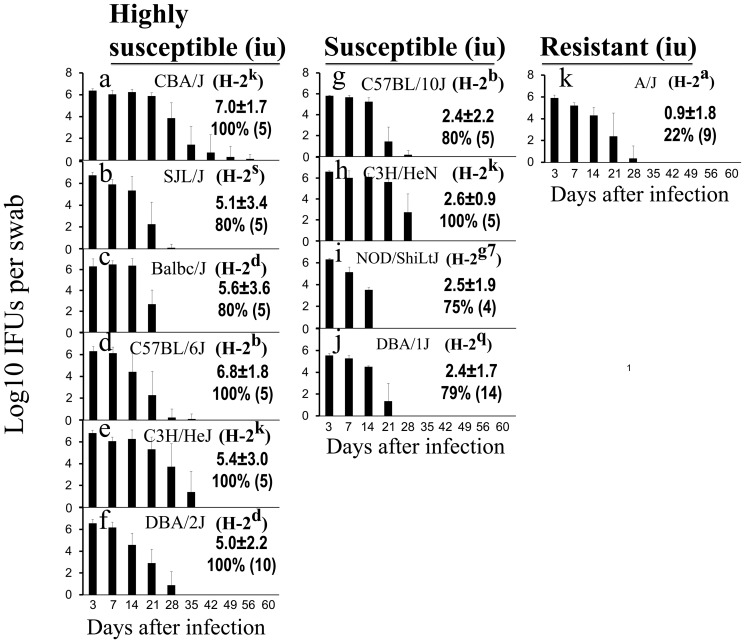
Hydrosalpinx development and live organism shedding following intrauterine infection with C. muridarum.Each of the 11 strains of mice was inoculated with 2×105 IFUs of C. muridarum via an intrauterine route (iu). Sixty days after inoculation, all mice were sacrificed for observing hydrosalpinx as described in Fig. 1 legend. Based on hydrosalpinx severity scores, the 11 strains were re-categorized into highly susceptible (with a median severity score of 5 or above, panels a-f for mouse strains CBA/J, SJL/J, Balb/cJ, C57BL/6J, C3H/HeJ & DBA/2J respectively), susceptible (<5 and >1, panels g-j for C57BL/10J, C3H/HeN, NOD/ShiLtJ & DBA/1J) or resistant (<1, panel k for A/J). The hydrosalpinx incidences (%) along with total number of mice per strain (in bracket) are listed under the corresponding hydrosalpinx scores. The live organism shedding was monitored post infection as described in Fig. 3 legend and expressed as Log10 IFUs (shown along the Y-axis of each panel). The H-2 haplotypes are listed after the corresponding mouse strain name. Note that the hydrosalpinx severity did not have any obvious correlations with the live organism shedding course or H-2 haplotypes except for H-2d. Both Balb/cJ (H-2d) and DBA/2J (H-2d) were highly susceptible to hydrosalpinx induction.